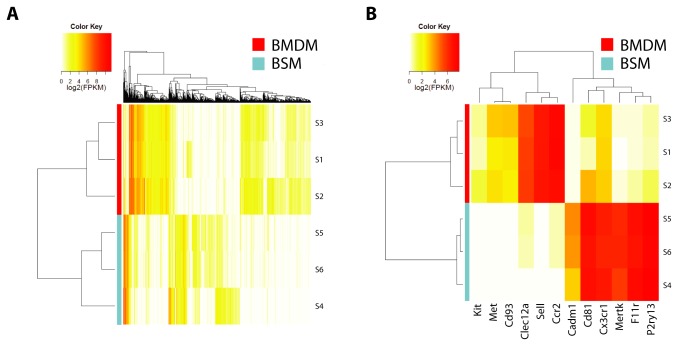
Differentially-expressed brainstem microglia (BSM) and bone marrow monocyte (BMDM) transcripts.(A) A heat map was generated from unsupervised hierarchical clustering analysis that included all genes expressed (FPKM >1 in ≥1/6 samples). (B) Candidate genes selected for further validation for comparison to CX3CR1 and CCR2.